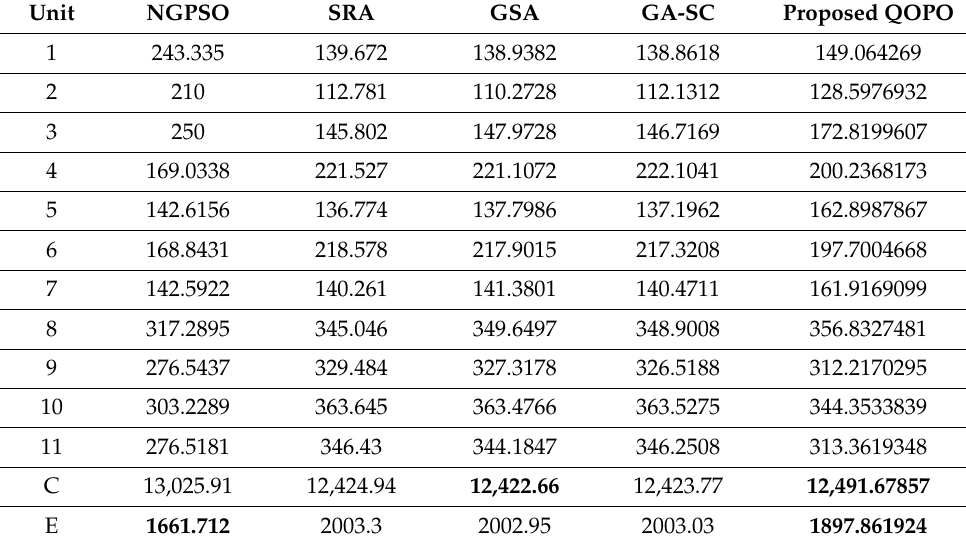
Table 12. Comparison of results of the 11-unit system for the load demand of 2500